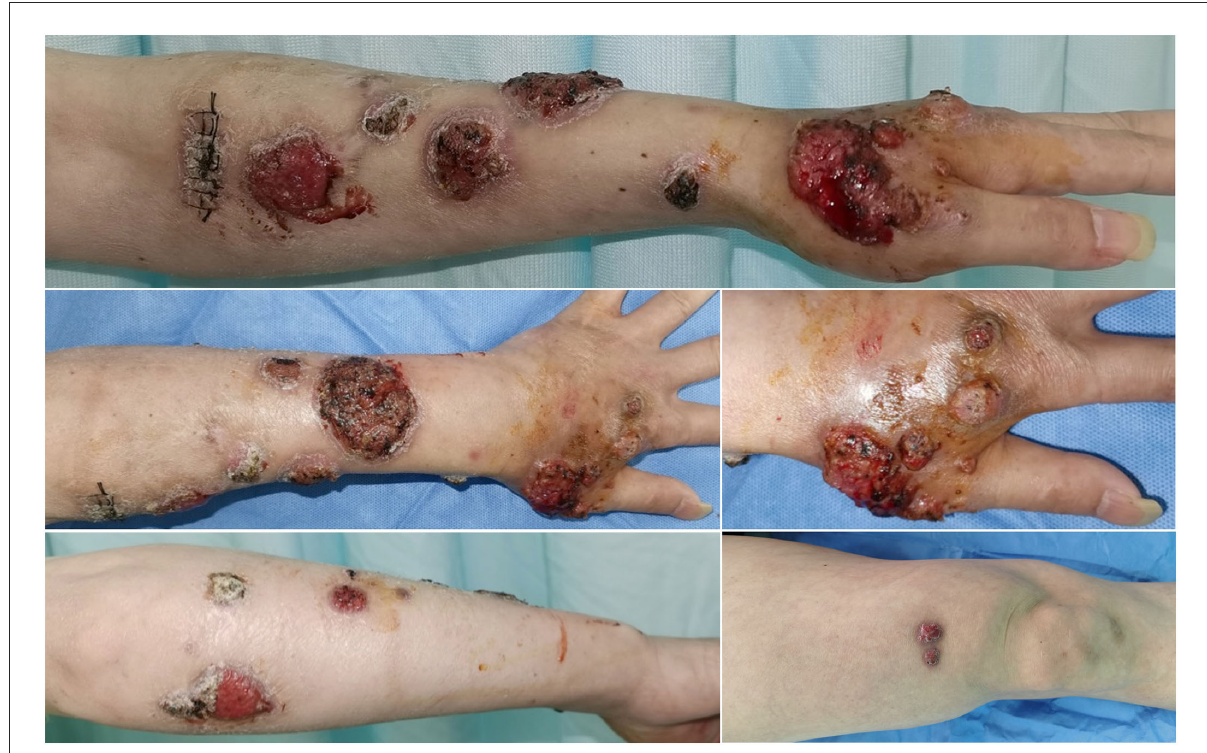
FIGURE1 Multiple cutaneous lesions caused by Sporothrix globosa . A 47-year-old man with multiple verrucous and ulcerated nodules with overlying necrotic eschar on left upper limb, scattered crusted papules and plaques on right